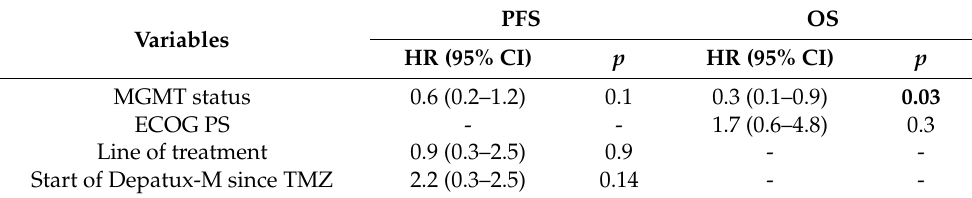
Table 3. Multivariate analysis for PFS and OS.